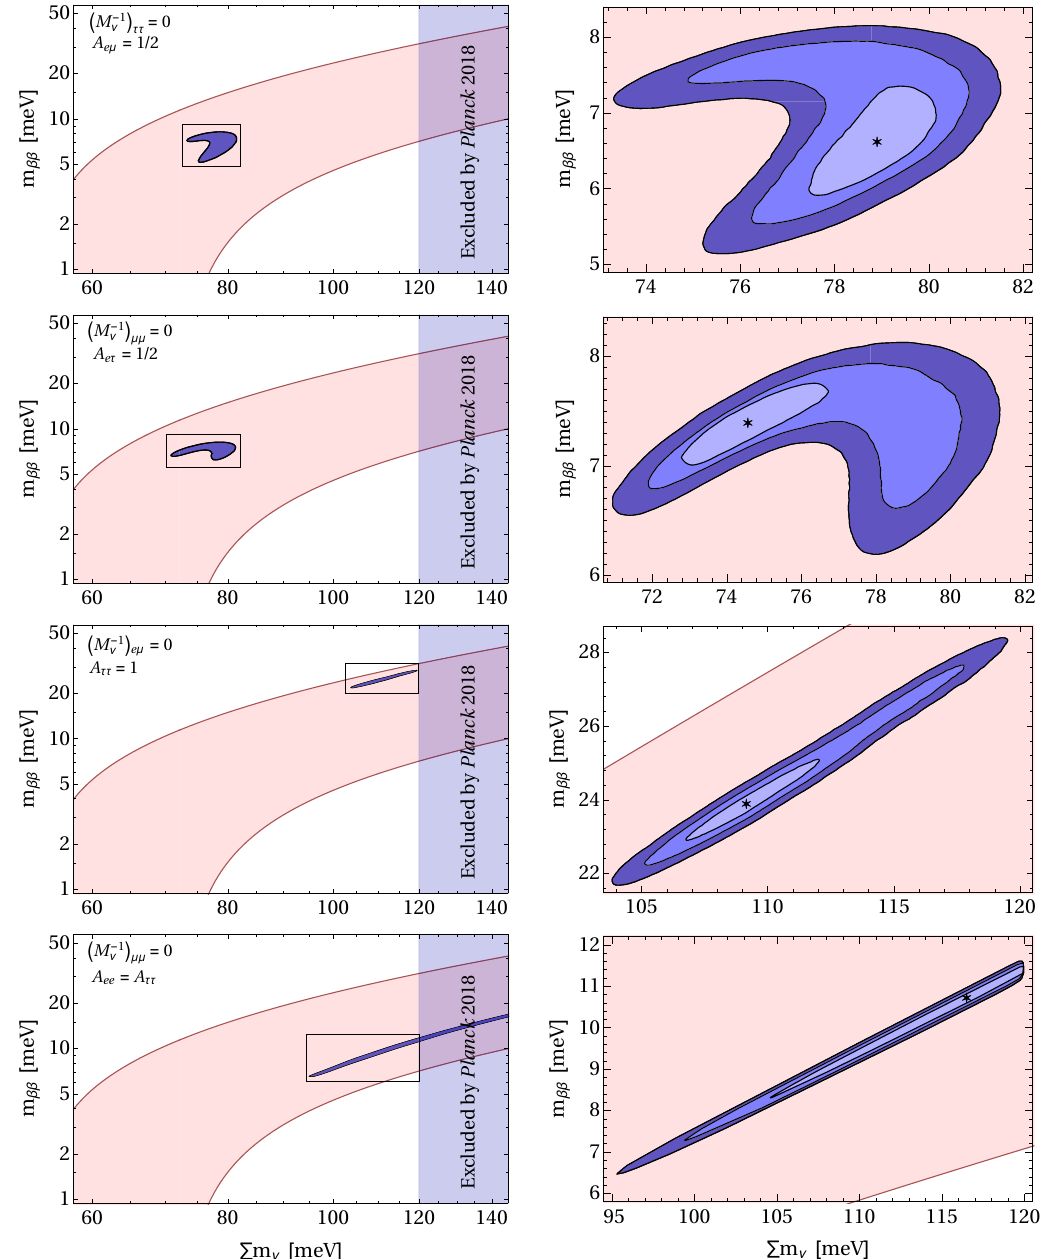
Figure 4 . In the four rows one sees the predictions of models 1, 2, 3, and 4, respectively, for the sum of the light-neutrino masses and for the mass parameter responsible for neutrinoless 2 (cid:12) decay. Pink areas are allowed by phenomenology alone; blue areas include the conditions of each model. The right panels are zooms of the marked areas in the left